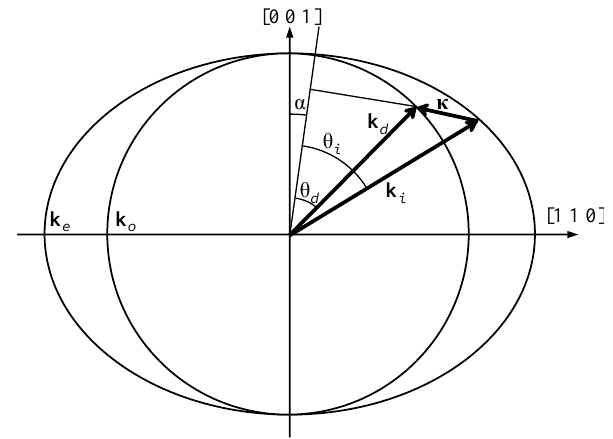
Figure 1. The wave vectors generated by the AOTF experiment. From Eq. (1), the incident wave vector, k i , diffracted wave vector, k d , and acoustic wave vector κ are shown. The respective interac- tion angles for the incident and diffracted wave vectors θ i and θ d are also presented.